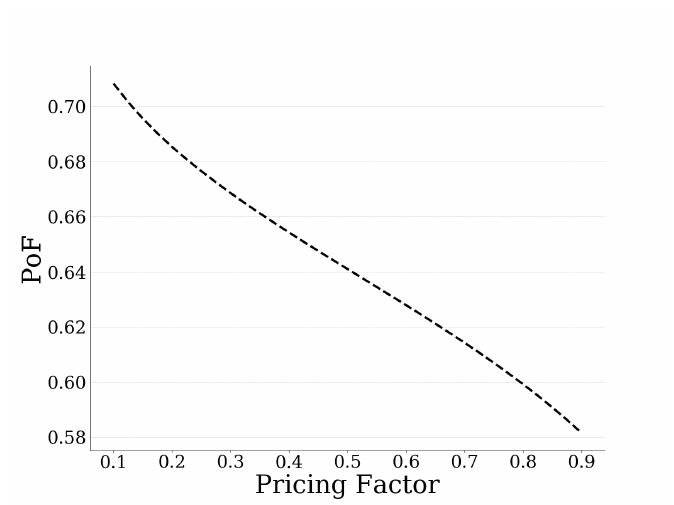
Figure 8. Probability of failure of MEC server vs. the pricing factor.